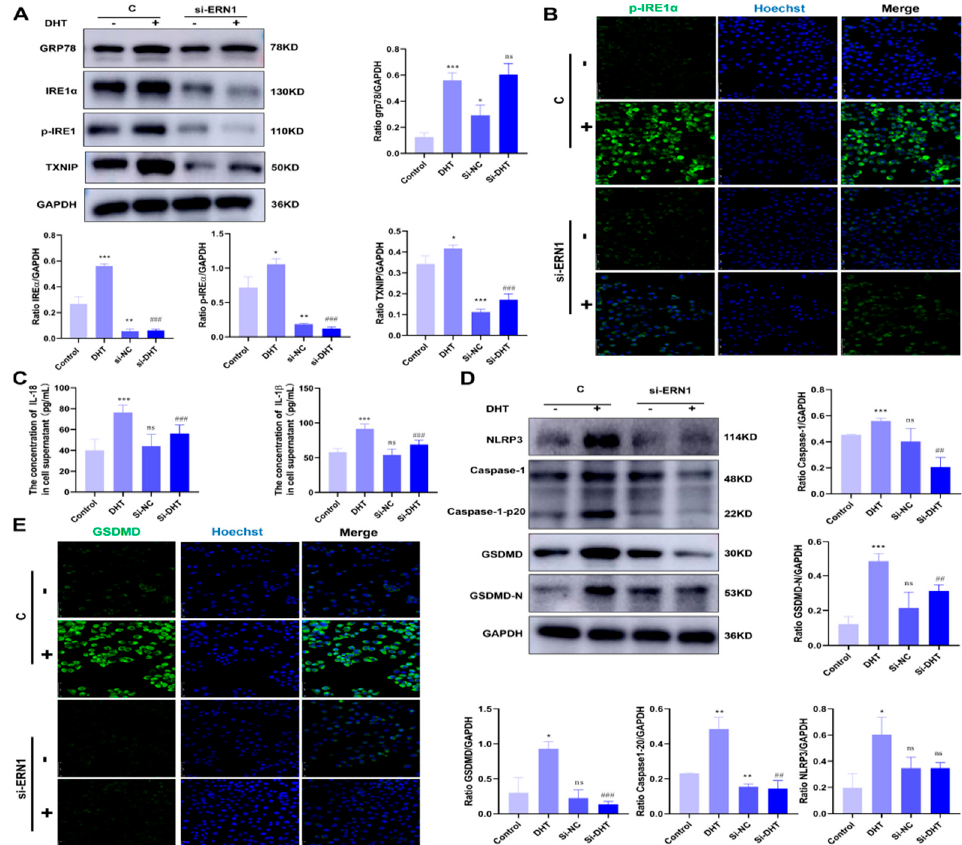
Figure 6. CYA can alleviate ovarian granulosa cell pyroptosis and the local ovarian inflammatory response by inhibiting the activation of the IRE1 α signaling pathway in PCOS. After ERN1 (IRE1 α gene) was knocked down by siRNA in KGN cells, DHT was added to the cell culture medium, the concentration of DHT was 10 uM, and the action time was 24 h. ( a ) The expression of IRE1 α sig- naling pathway proteins in ovarian GCs was assessed with Western blot; ( b ) the expression of p-IRE1 α in ovarian GCs was assessed with immunohistochemical tests; ( c ) the expressions of IL-18 and IL-1 β in cell supernatants were analyzed using enzyme-linked immunosorbent assay kits in four groups; ( d ) the expressions of NLRP3 inflammasome and pyroptosis-related proteins in ovarian GCs were assessed with Western blot; ( e ) the expression of GSDMD in ovarian GCs was assessed with immunohistochemical tests. Two independent experiments were performed with similar results. Data are shown as mean ± SEM. “*” indicates the group compared to the control group, “#” indicates the si-DHT group compared to the DHT group, */# p < 0.05, **/## p < 0.01 ,***/### p < 0.001.